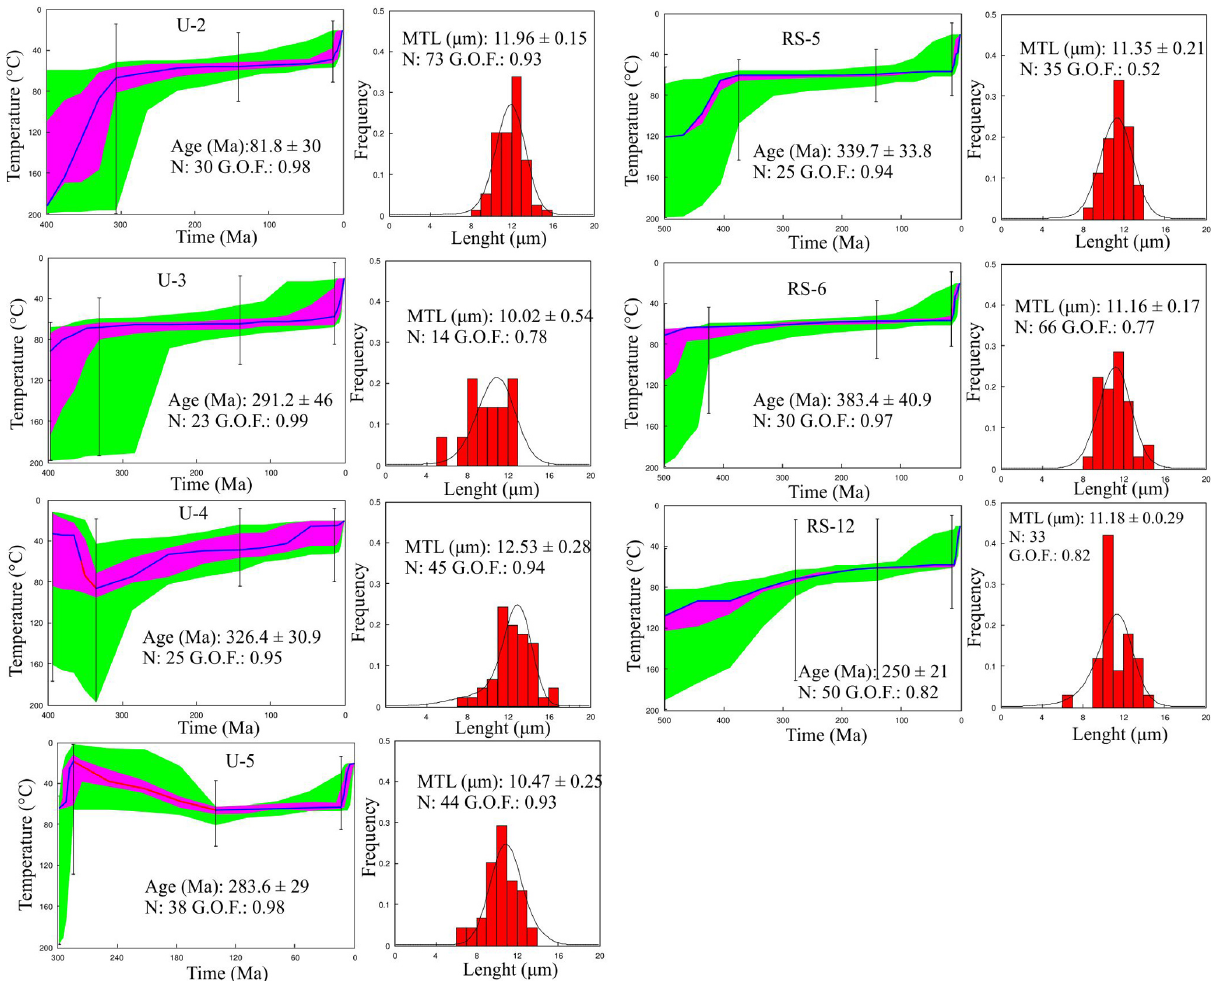
Figure 3. Thermal history of samples from the Western Domain. The numerical modelling used the software code AFTSolve (Ketcham et al., 1999). The temperature and time paths and the confined track length distributions are overlain by a calculated probability density function (best fit). The diagram on the left show four different fits: green paths are the acceptable fit; pink paths are the goodness of fits; and blue-red line is the best fit. The red line represents the moment of the heating. G.O.F.: goodness of fit, N : number of single grain ages and measured track length